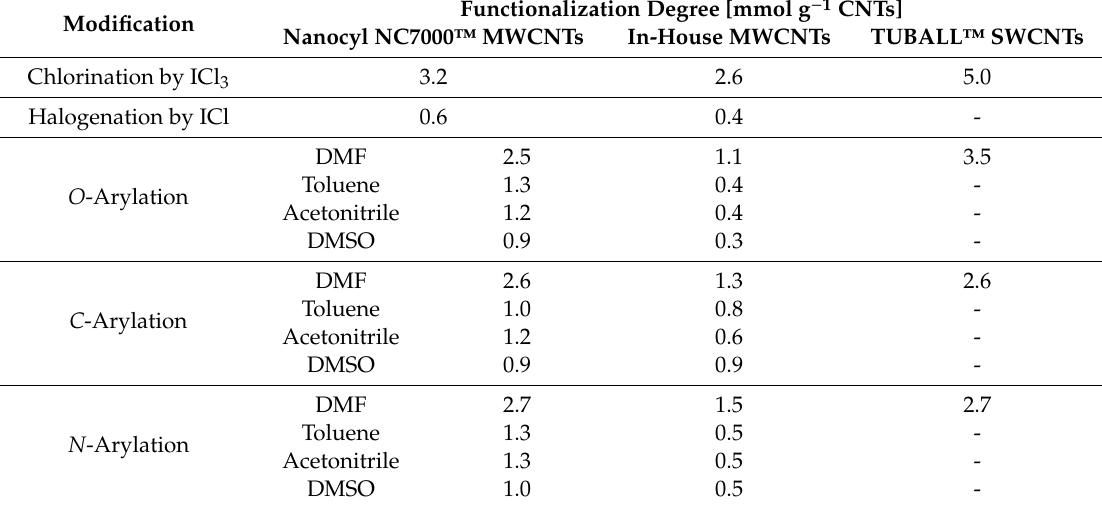
Table 2. Functionalization degrees (mmol g − 1 CNTs) of functionalized CNTs as determined from TGA.